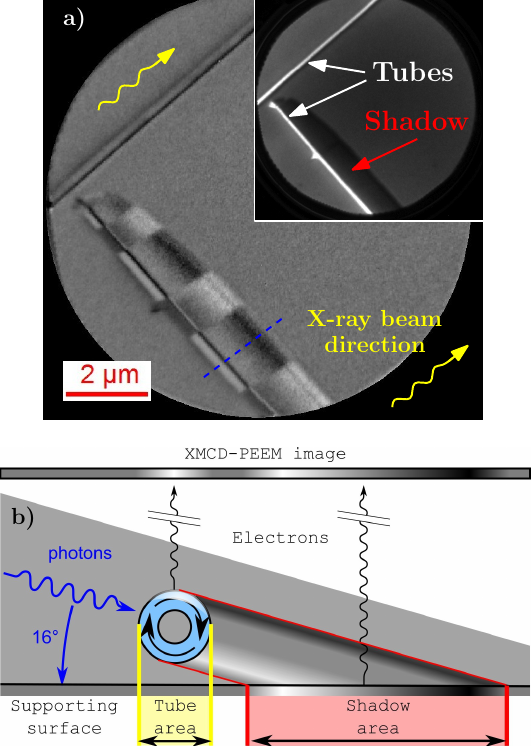
Fig. 2: Magnetic azimuthal flux-closure domains. a) XMCD-PEEM (Co-L